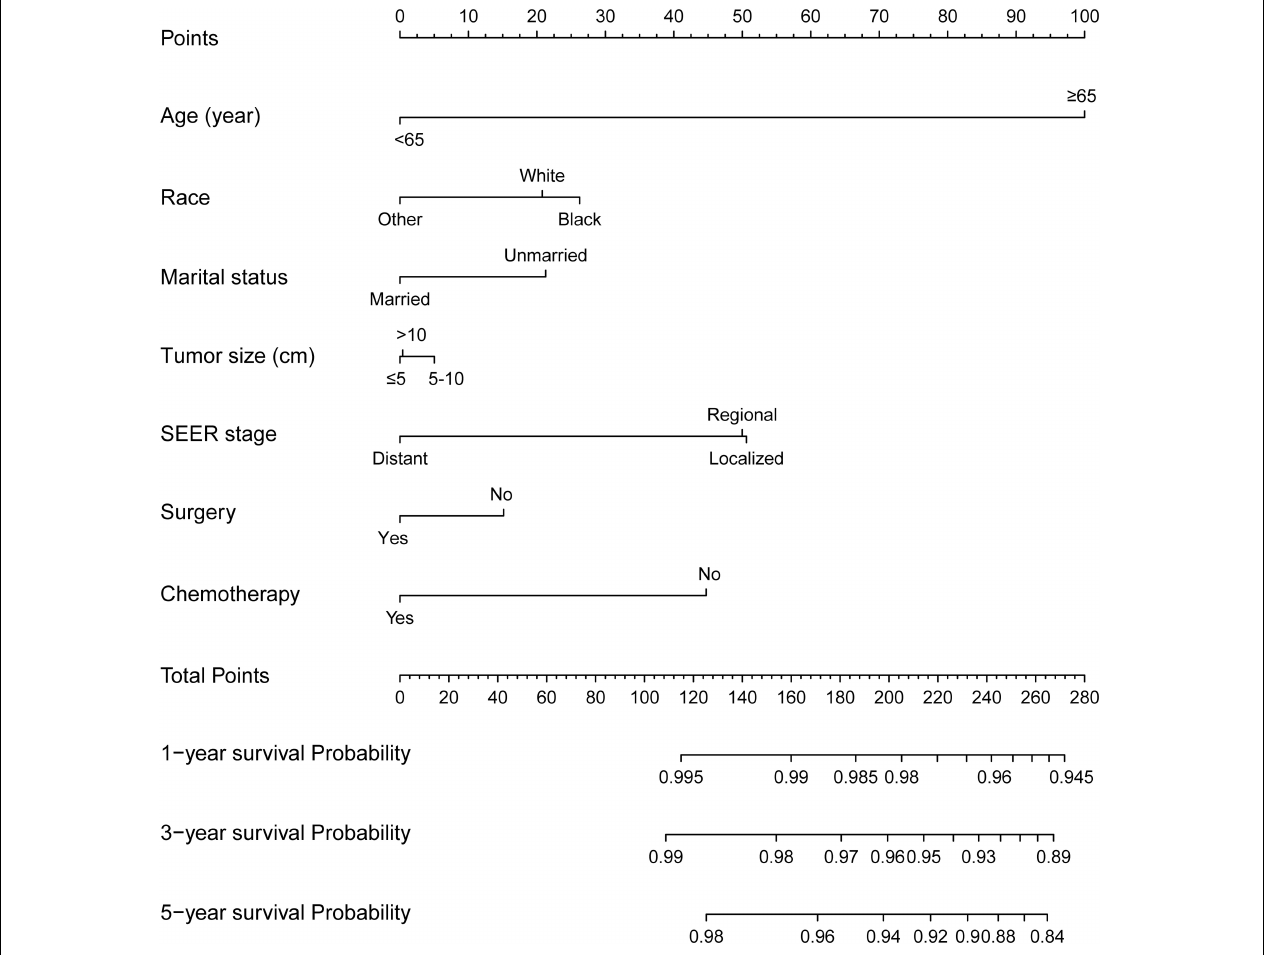
FIGURE 3 | Competing-risk model for predicting the 1-, 3-, and 5-year probabilities of CVD among patients with CRC. The “total points” of a certain patient was calculated by adding all the scores of the 7 parameters. Based on the total points, the possibilities of CVD at different timepoints and the prognostic group was